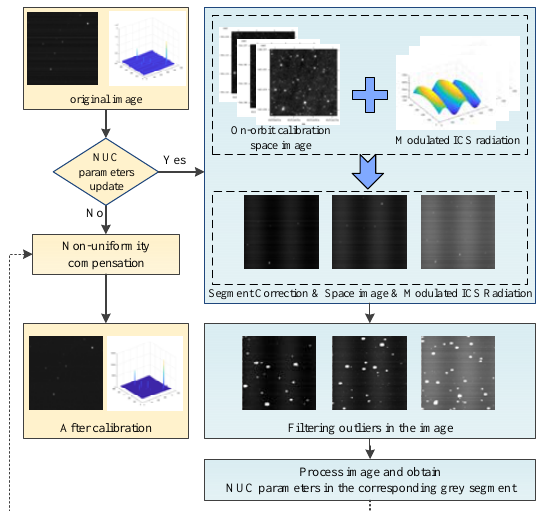
Figure 3. Processing flow chart of the non ‐ uniformity correction (NUC) method with modulated internal calibration sources.